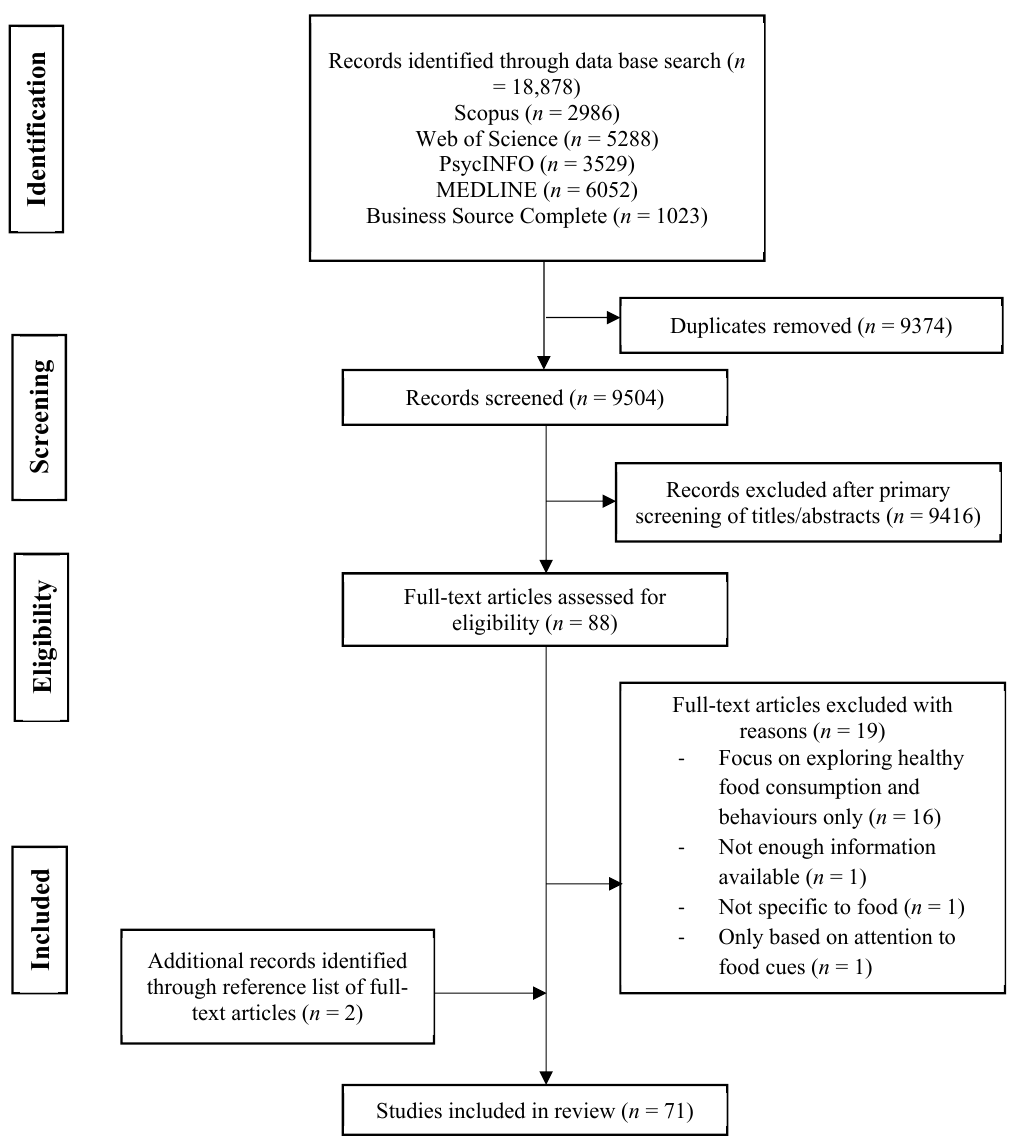
Figure 1. PRISMA flow chart of the systematic review literature search.